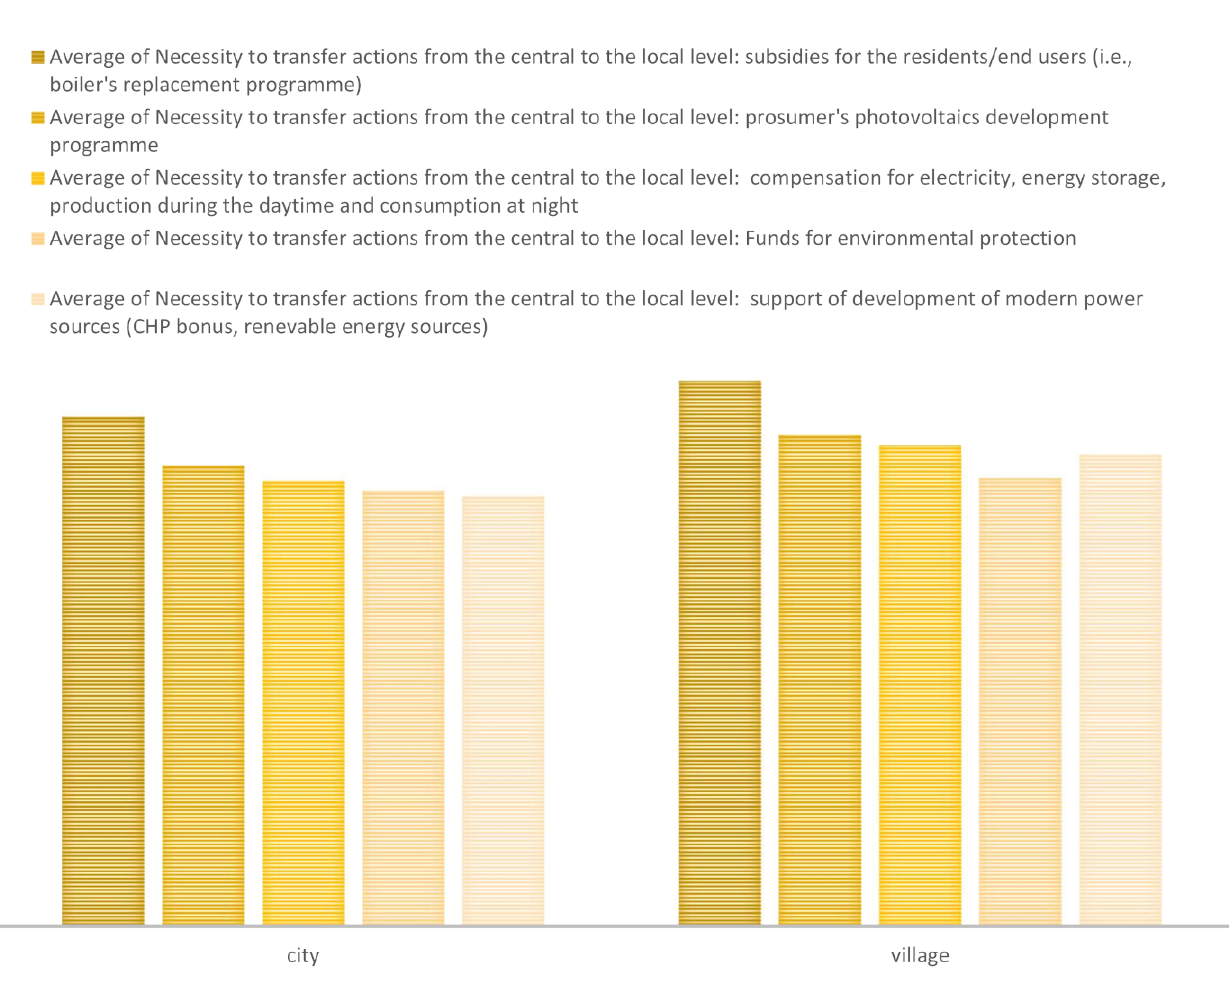
Figure 4. Average of Necessity to transfer actions from the central to the local level. Source: Own research based on the results of an online survey, n = 444 (444 respondents who filled in the questionnaire online, of which 205 were men and 239 were